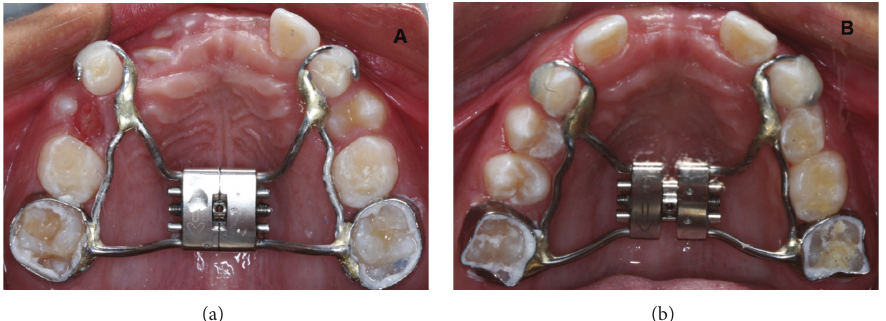
Figure 6: Palatal view of the Hyrax-type palatal expansion appliance in both twins.